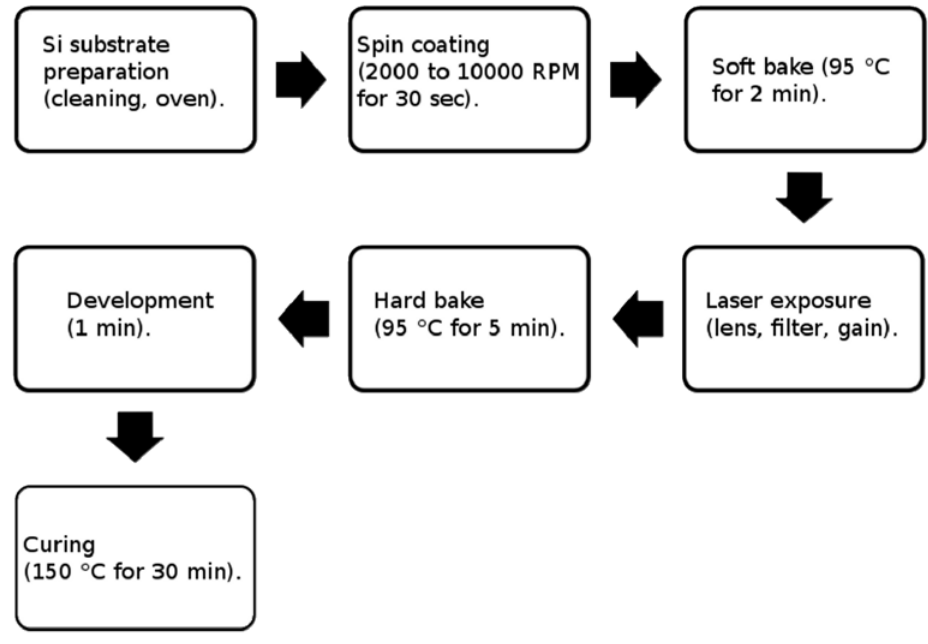
Figure 1. Process flow for ORMOCOMP ® microstructure patterning through direct laser